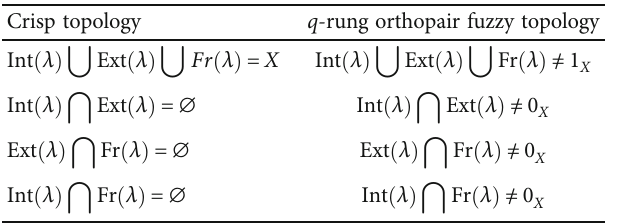
Table 2: Comparison of some results of crisp topology and q-ROF topology. Crisp topology q -rung orthopair fuzzy